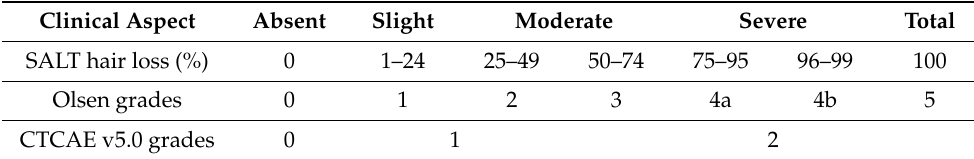
Table 2. Comparison of SALT, Olsen and CTCAE v5.0 scores to assess the severity of chemotherapy- induced alopecia (adapted from references [16,17]).